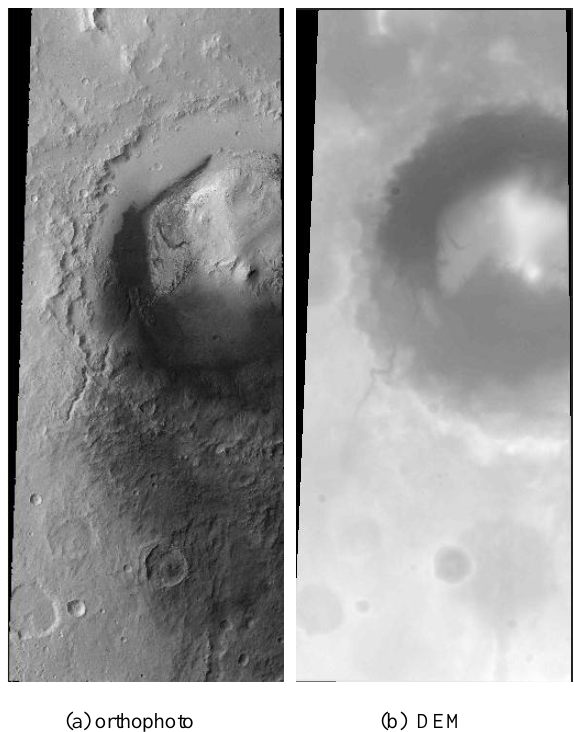
Figure 11. Mars Express orbit 5273 resampled with 25m/pixel